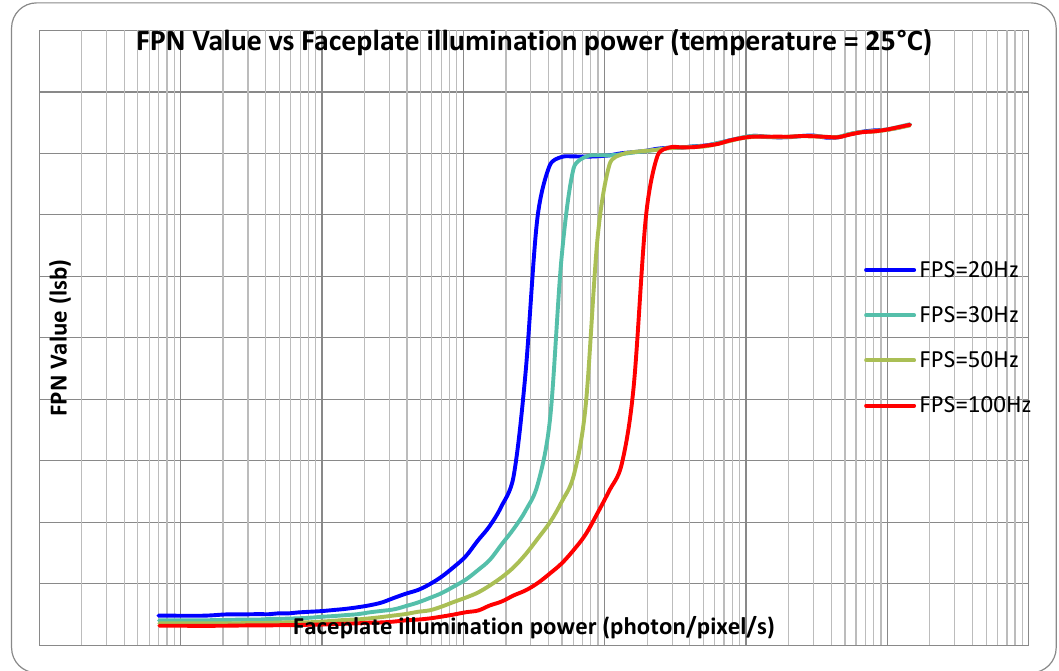
Figure 9. Measured fixed-pattern noise from the QLog test chip at different exposure times.